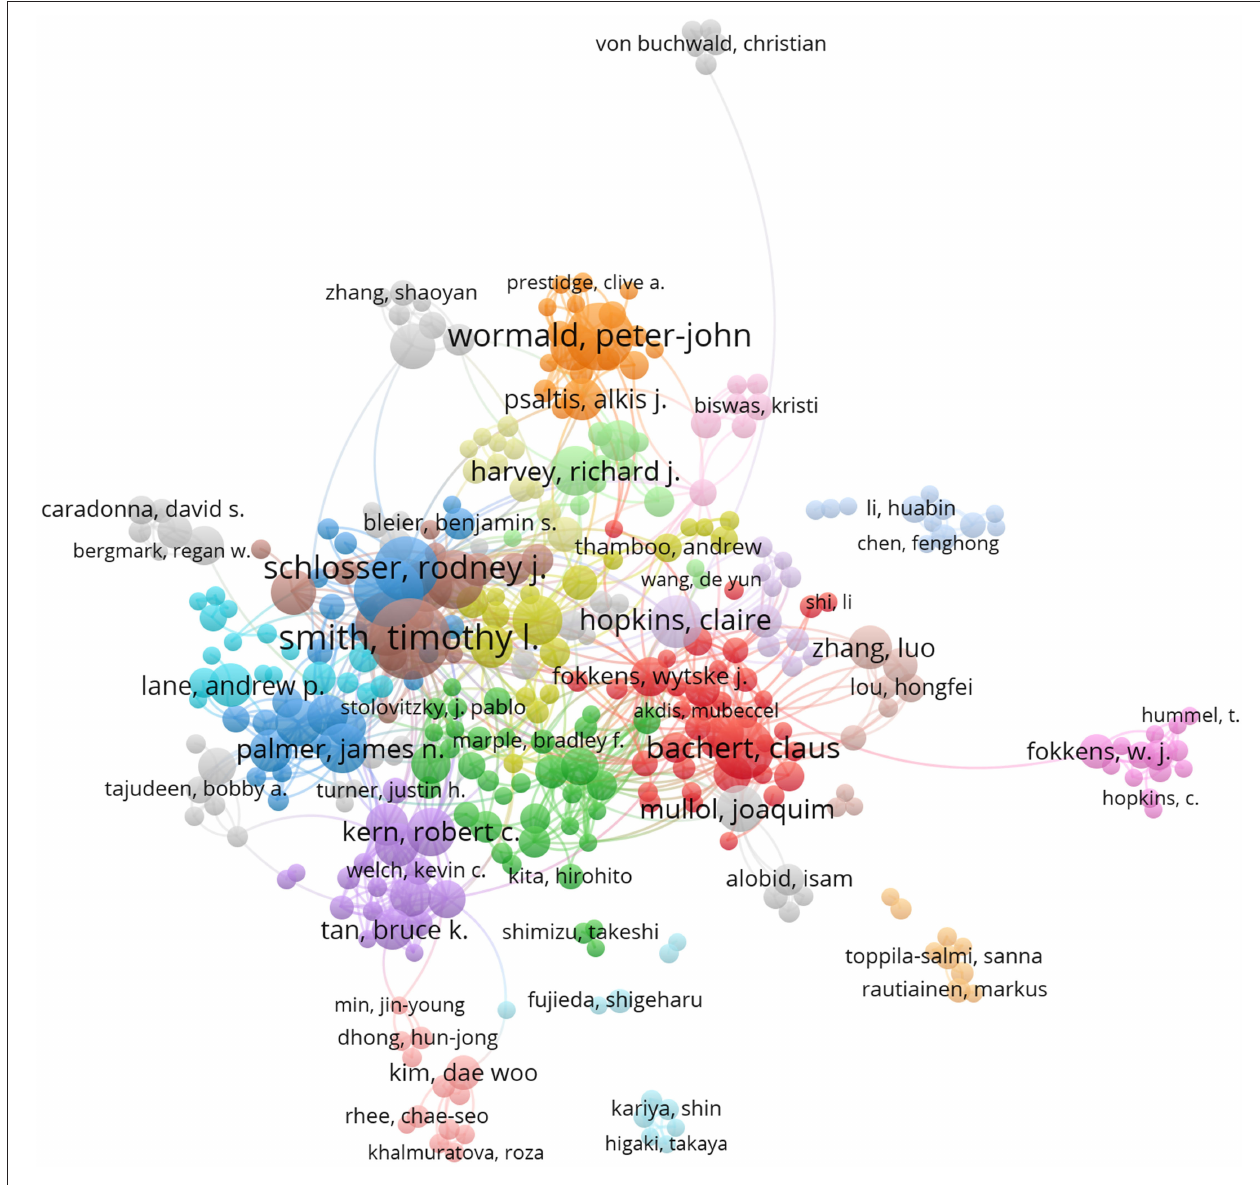
FIGURE 4 | Joint mapping of productive authors in CRS-treatment research from 2001 to